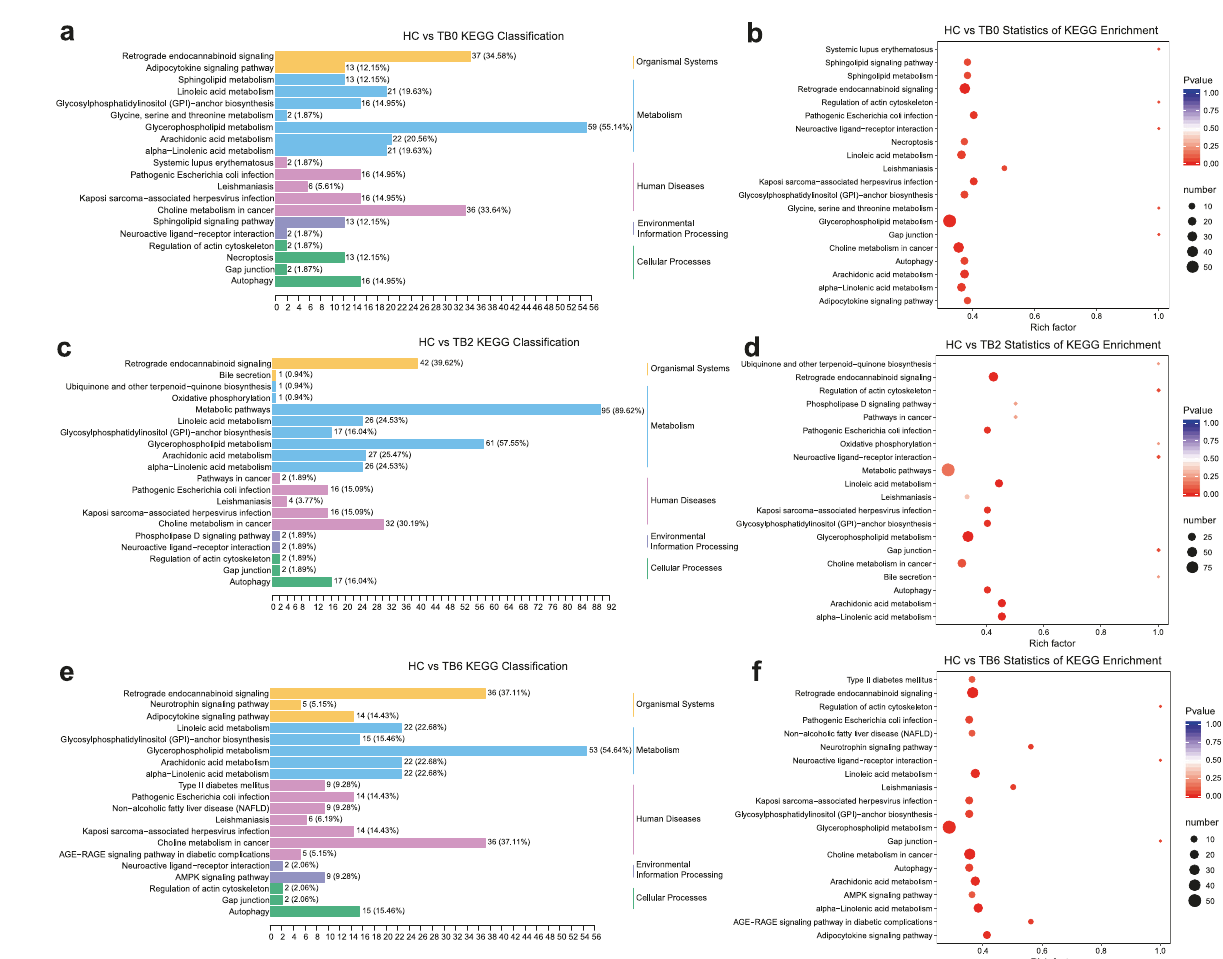
Fig. 4 The lipidome KEGG enrichment analysis of TB patients. a , b KEGG pathway analysis of TB0 unique to the HC groups. The color of bubbles represents the value of adjusted P value, and the size of bubbles represents the number of counts. c , d KEGG pathway analysis of TB2 unique to the HC groups. e , f KEGG pathway analysis of TB6 unique to the HC